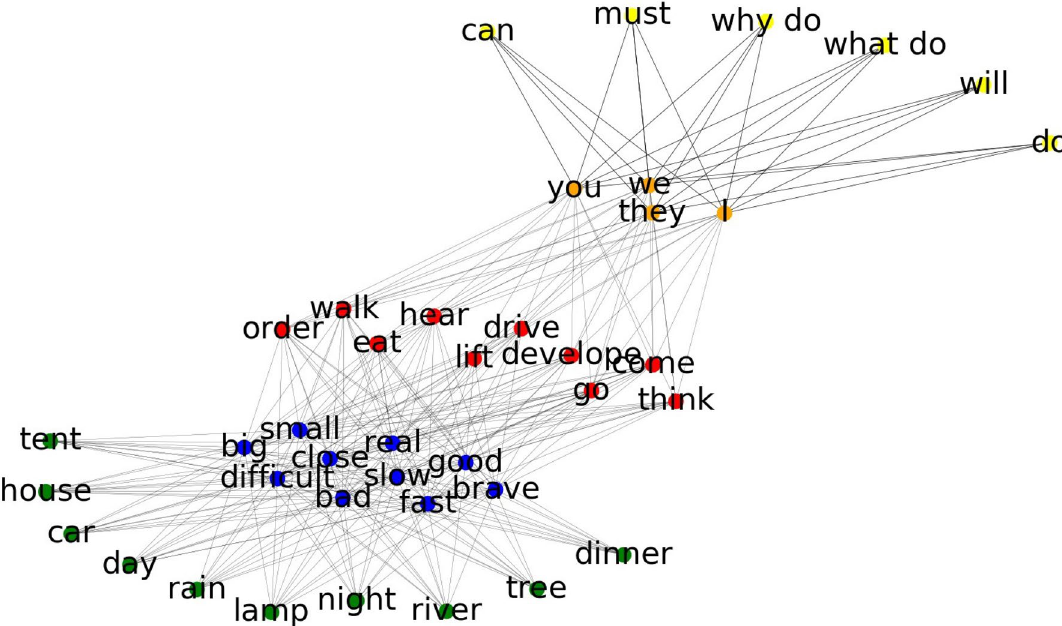
Figure 6. Network-like map of linguistic constructions: The simplified language model consists of five different word classes and three linguistic constructions defining allowed word class transitions. The word transition matrix can be visualized as a graph or network-like map, whereas each word corresponds to a node, and edges represent possible word transitions. Different node colors indicate different word classes. Note that, edges for transition probabilities smaller than 10 − 4 are not shown for better